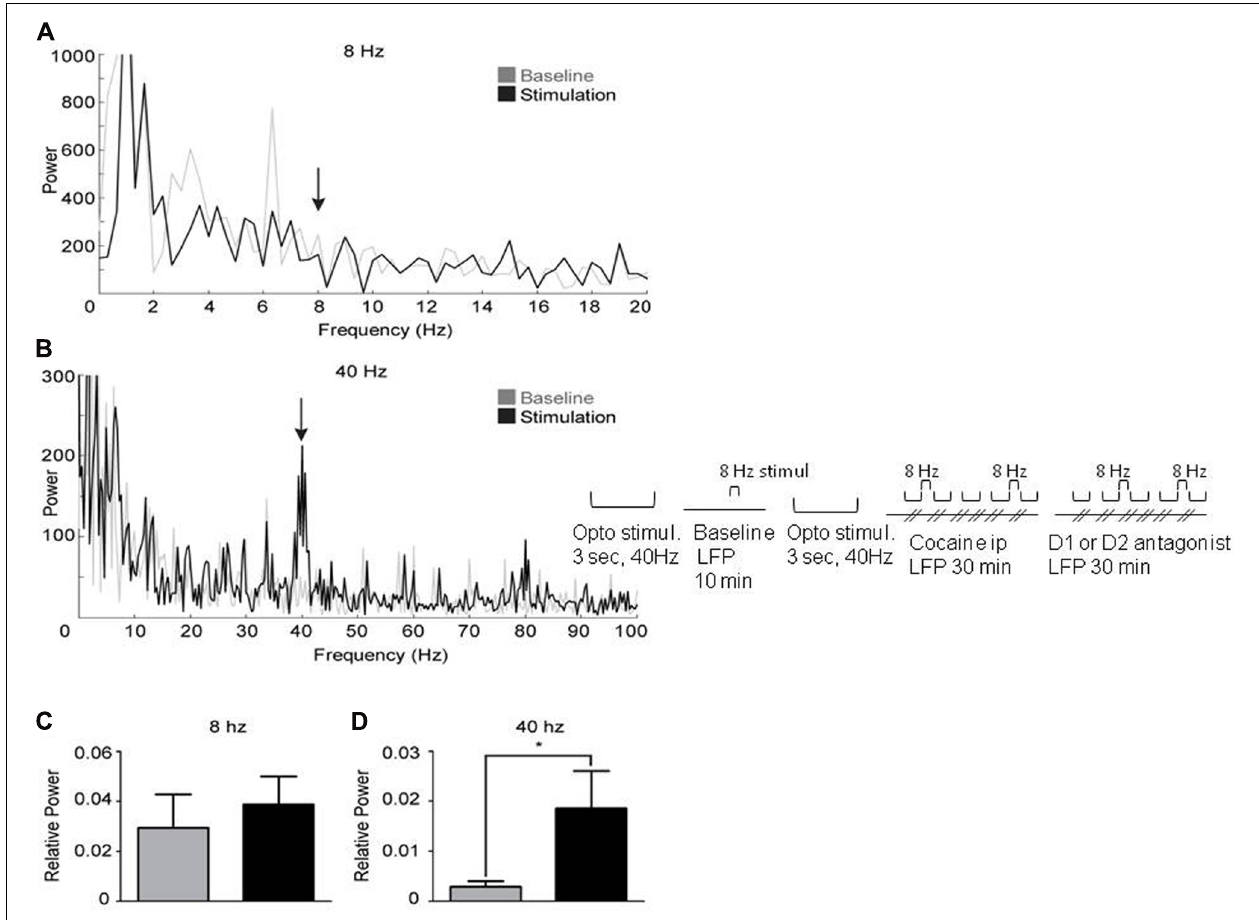
FIGURE 3 |Activation of PV + interneurons in the medial prefrontal cortex generates gamma oscillations. Power spectral densities from 3 s epochs occurring just prior to (gray) or during (black) optical stimulation delivered at 8 Hz (A) or 40 Hz (B) . (A) 8 Hz stimulation was ineffective at inducing oscillations. (B) Stimulation at 40 Hz induces a clear peak in the